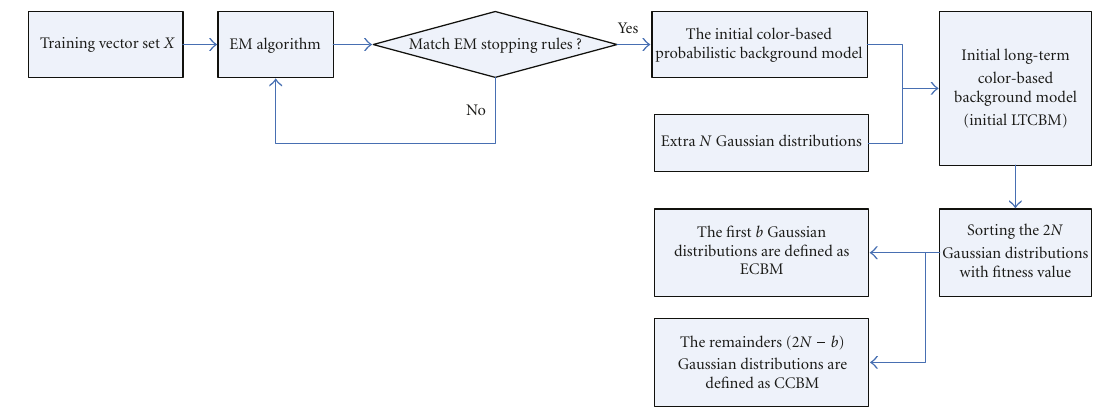
Figure 2: Block diagram showing the process of building the initial LTCBM, ECBM and